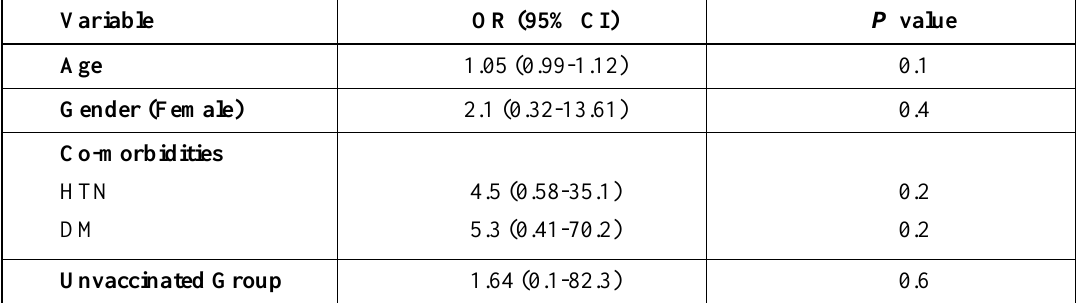
Table IV. Univariate logistic regression for predictors of developing severe COVID-19 infection.